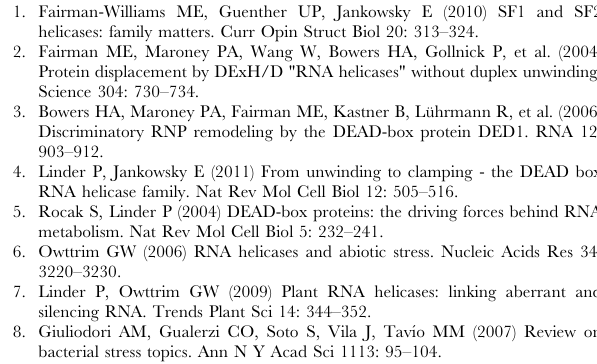
Figure S1 Ethidium bromide stained gel corresponding to the crhR induction time course at 10 u C. Total RNA (5 m g) extracted from wild type and D crhR Synechocystis cells was separated on a 1.2% formaldehyde agarose gel at 100 V for 2.5 h. The gel was stained with ethidium bromide and imaged using a LKB 2011 Macrovue UV transilluminator equipped with a Kodak EDAS DC 290 camera and processed using Kodak 1D 3.6 imaging software. The ethidium fluorescence indicates that essentially equal amounts of RNA were loaded in each lane. Therefore, variations in rnpB transcript levels are not related to unequal RNA present in each lane. Table S1 Quantification of crhR transcript hybridization de- tected in the D crhR mutant shown in Figure 7B. Methods S1 Quantification of RNA and protein abundance. The methodology and calculations used to quantify the relative transcript and protein levels using Image J [32], utilizing rnpB and Rps1 accumulation as controls for transcript and protein loading, respectively, are